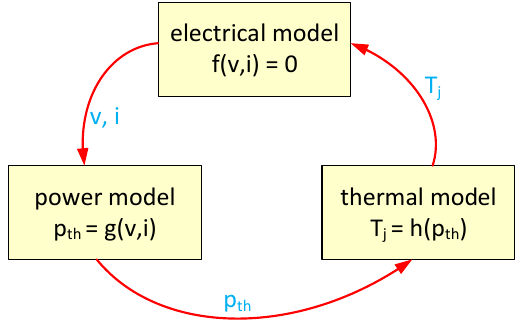
Figure 3. General form of the compact electrothermal model of a semiconductor device.